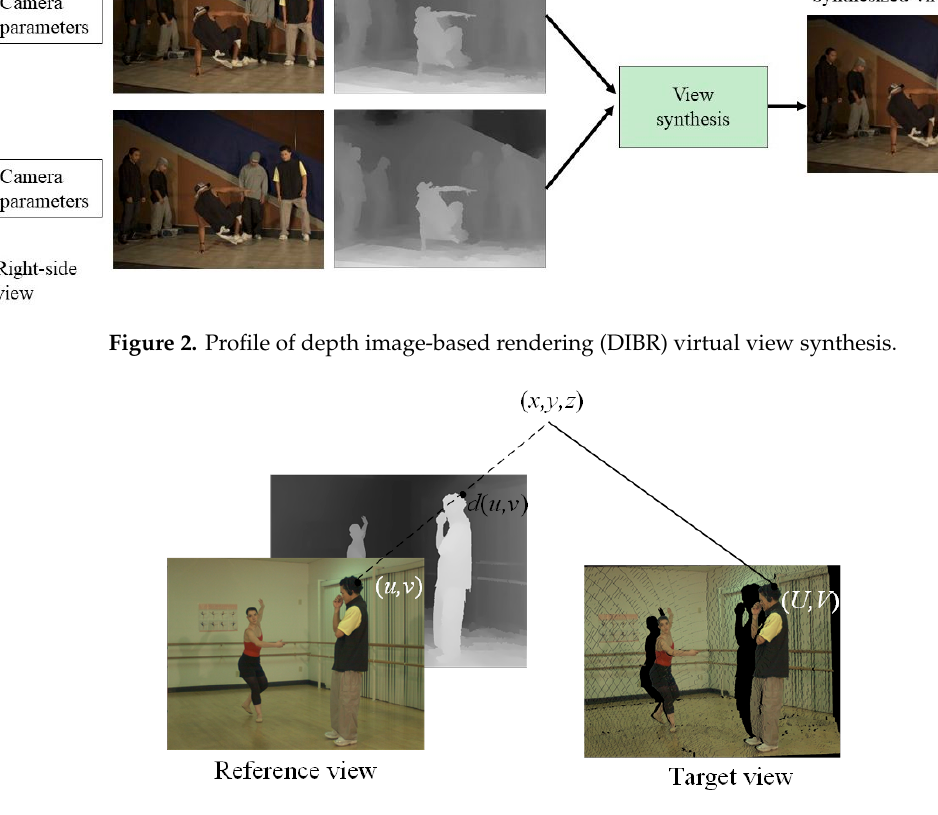
Figure 2. Profile of depth image-based rendering (DIBR) virtual view synthesis.